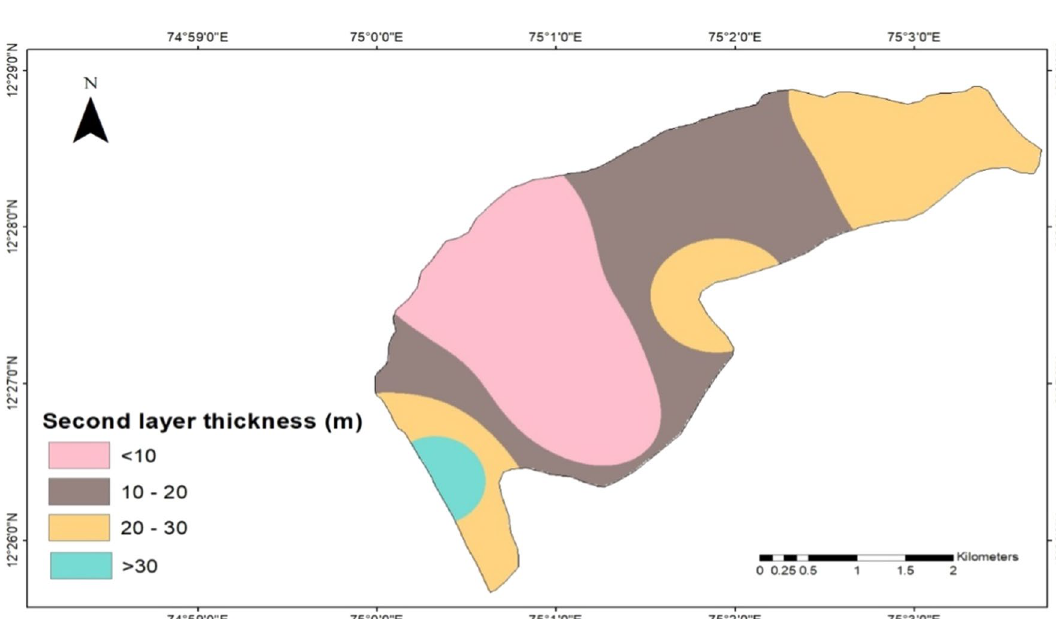
Fig. 7 Spatial variation map of thickness of second